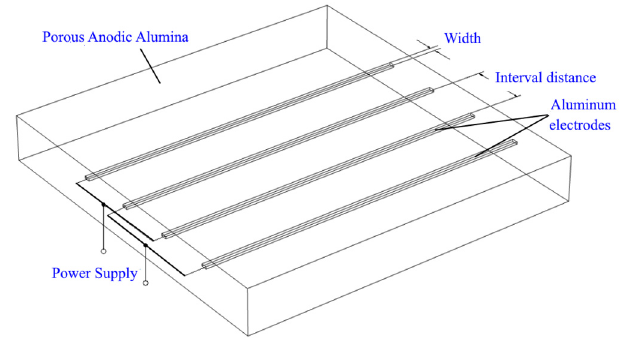
Figure 5. Coplanar capillary plasma electrode discharge device.